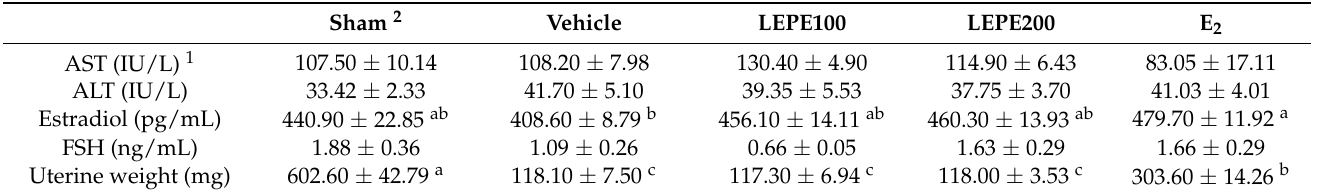
Table 1. Evaluation of hepatotoxicity and safety of LEPE in serum. Sham 2